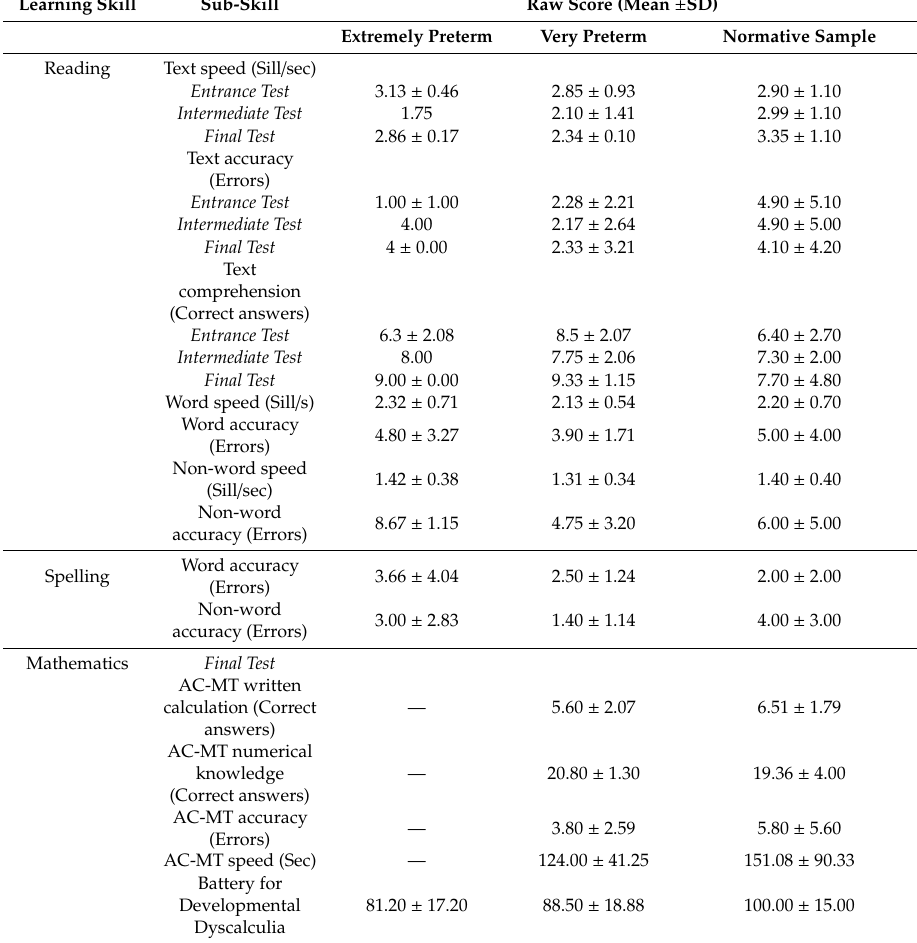
Table A1. Raw scores in learning skills in third grade children.